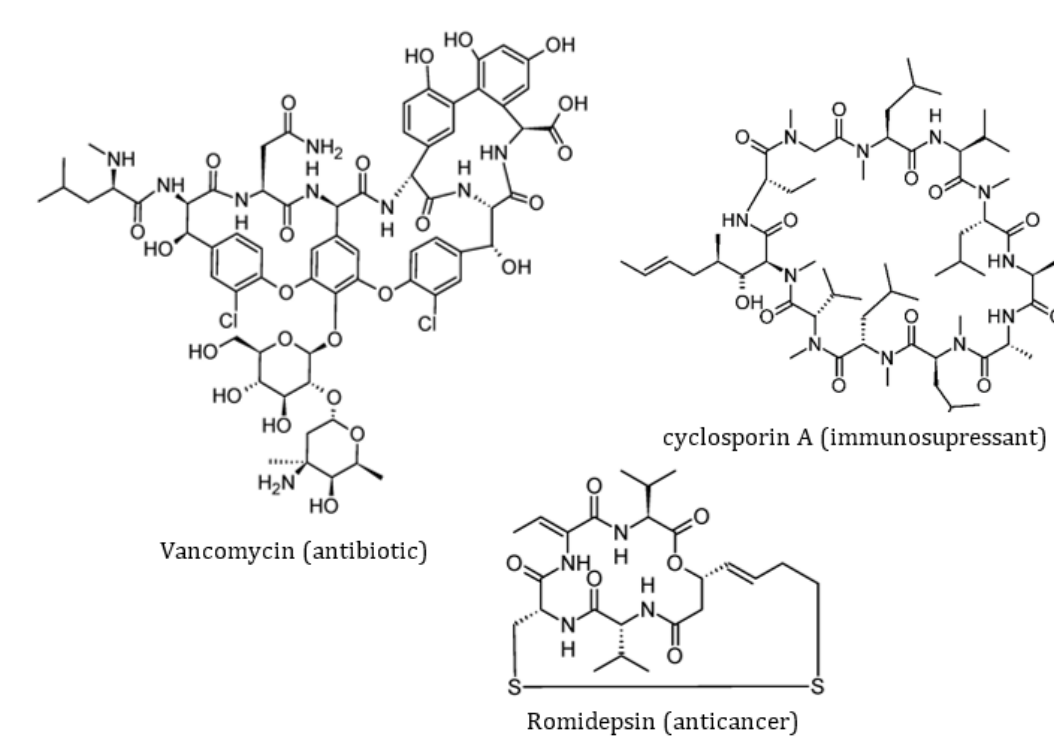
Figure 1. Cyclopeptide-derived microbial NPs as therapeutic